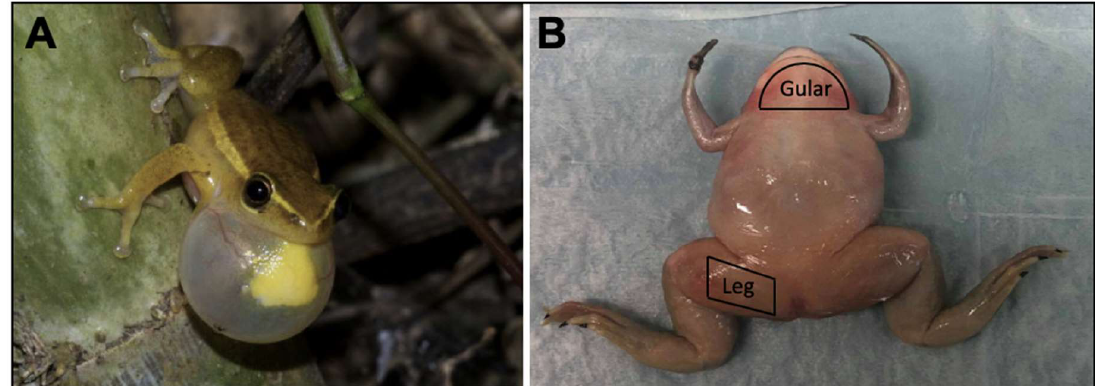
Figure 1. ( A ) A male Hyperolius Cinnamomeoventris, with inflated gular skin tissue to resonate its mating call. Reproduced from [5]. ( B ) Gross visual of tissue dissection areas. Shown here is the Xenopus